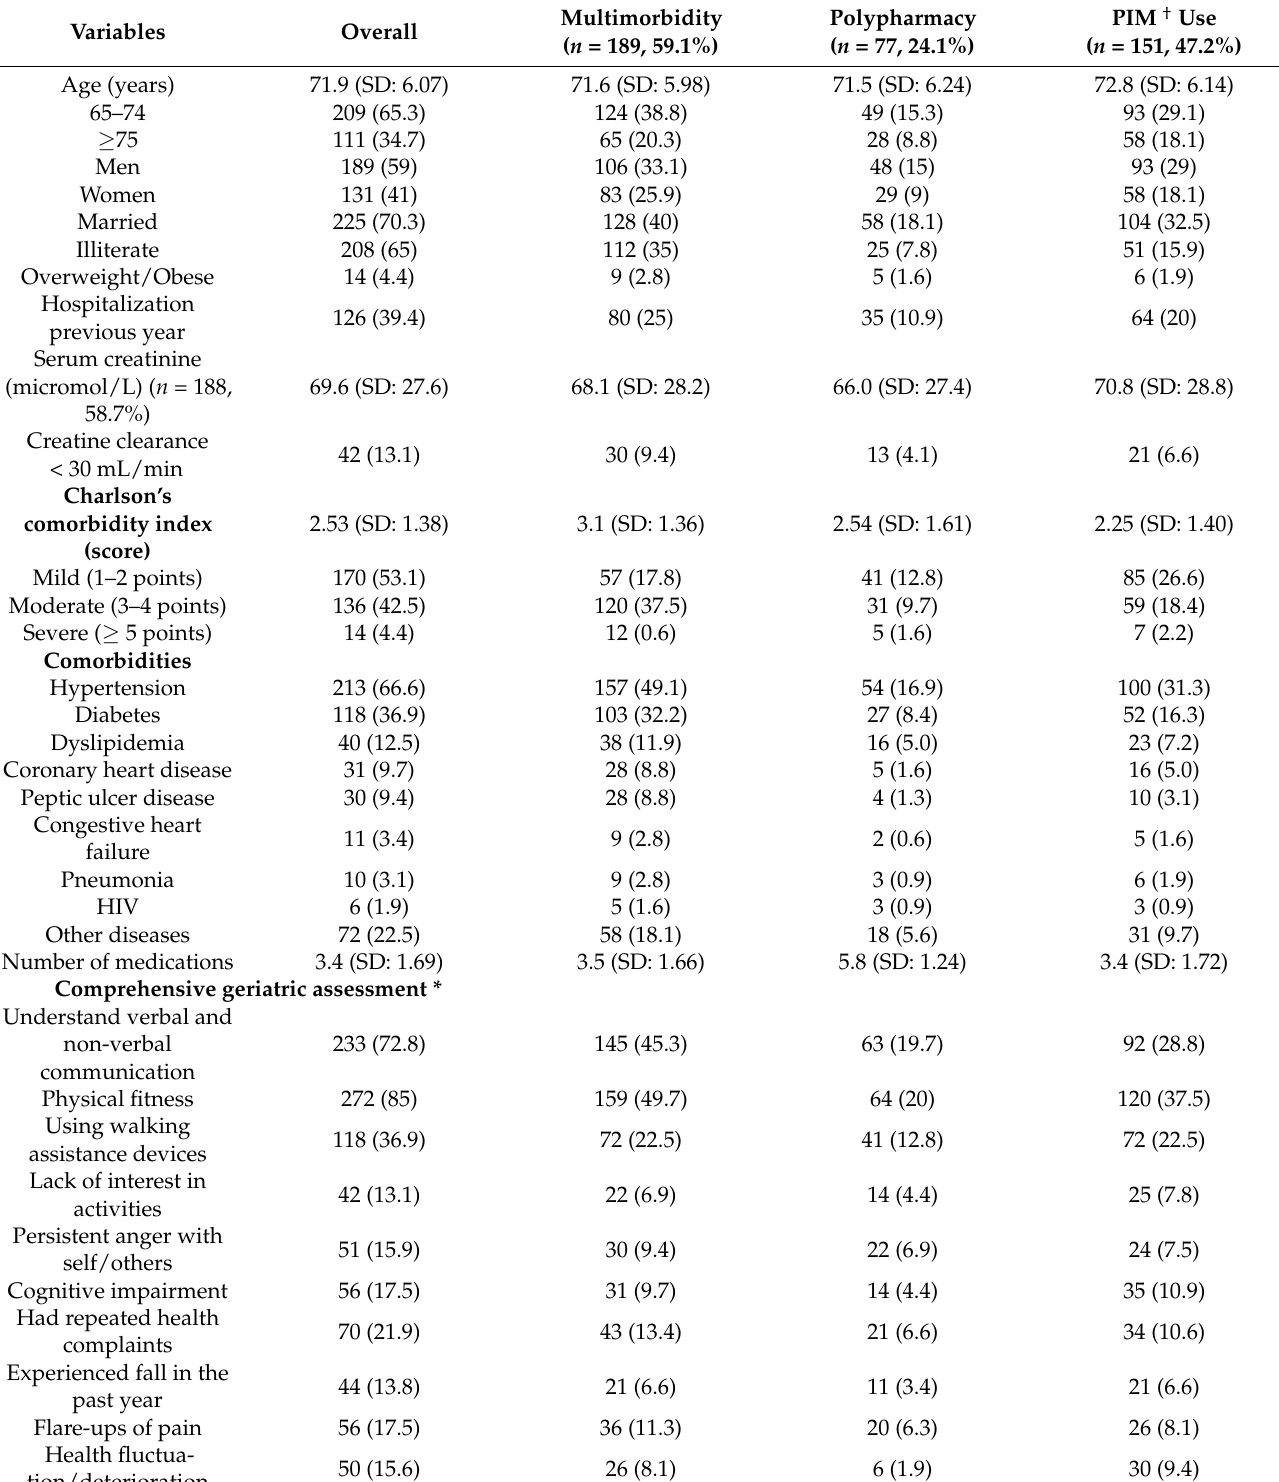
Table 1. Characteristics of ambulatory older patients with multimorbidity, polypharmacy, and PIM use according to 2019 AGS Beers criteria ( N =